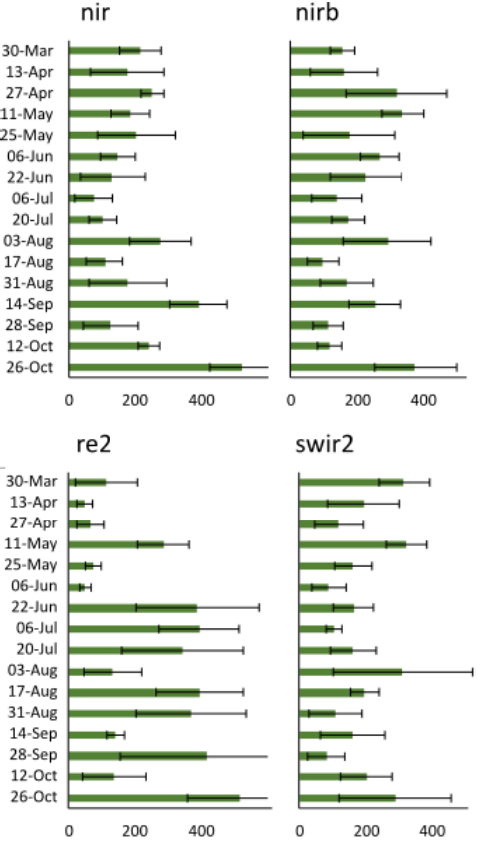
Figure 7: Shap analysis of the importance of each predictor relative to the model. Horizontal axis is unitless.